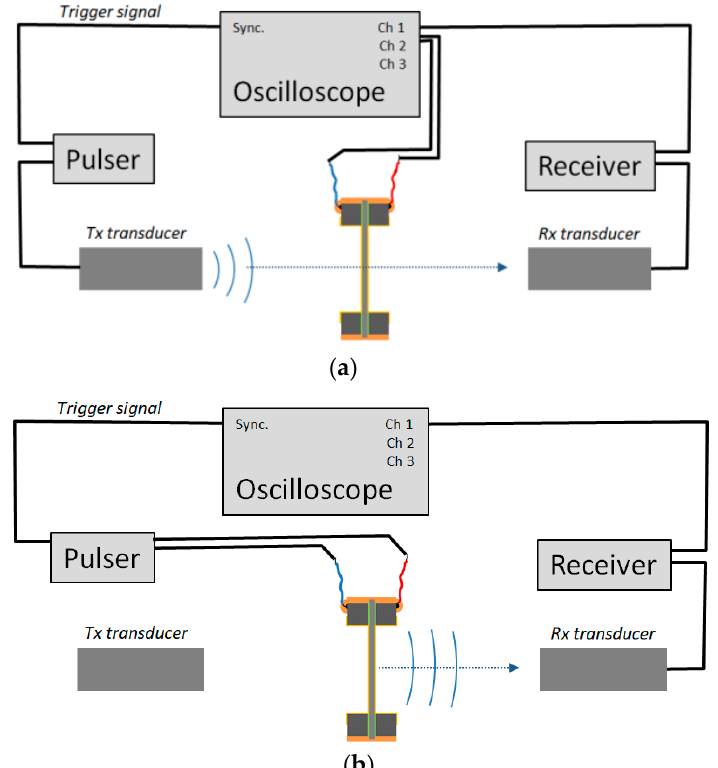
Figure 3. Experimental set-up. ( a ) Configuration for the measurement of both the transmission coefficient and the FE film and the film response in Rx mode; ( b ) configuration for the measurement of the FE film response in Tx mode.